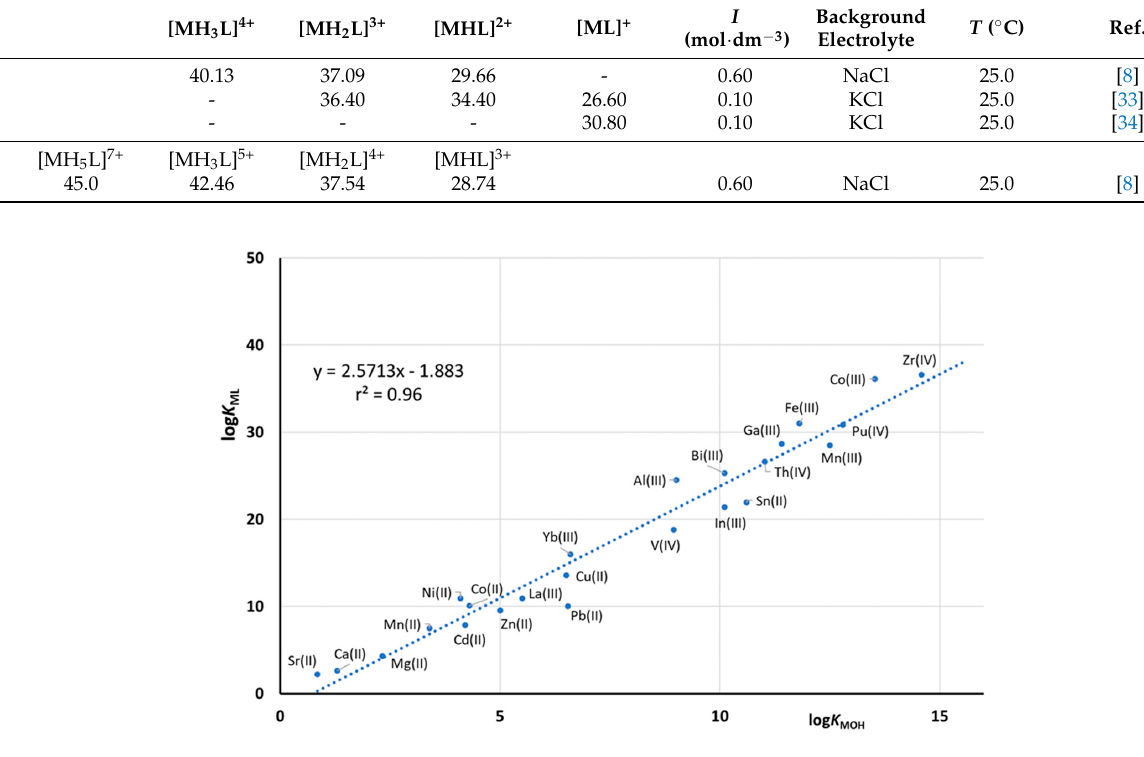
Table 7. Overall complex-formation constants (log β ) of DFOB with high valence metal ions, under different experimental conditions.